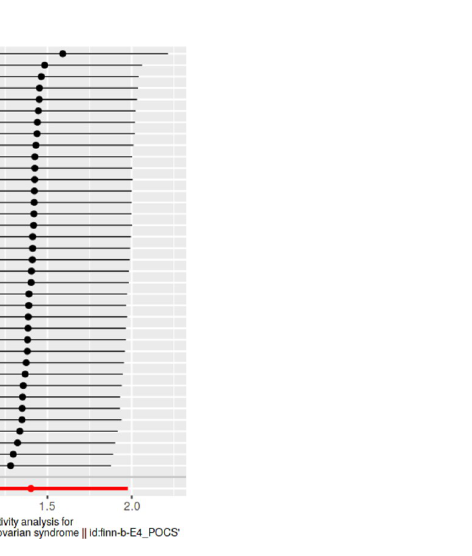
Fig 10. Leave-one-out sensitivity analysis plot of body mass index, against polycystic ovarian syndrome as the outcome. A given dark point indicates the effect measure from inverse variance weighted Mendelian randomization analysis excluding that specific SNP. The red lines indicate pooled analyses encompassing all SNPs via IVW-MR method (drawn for comparison).